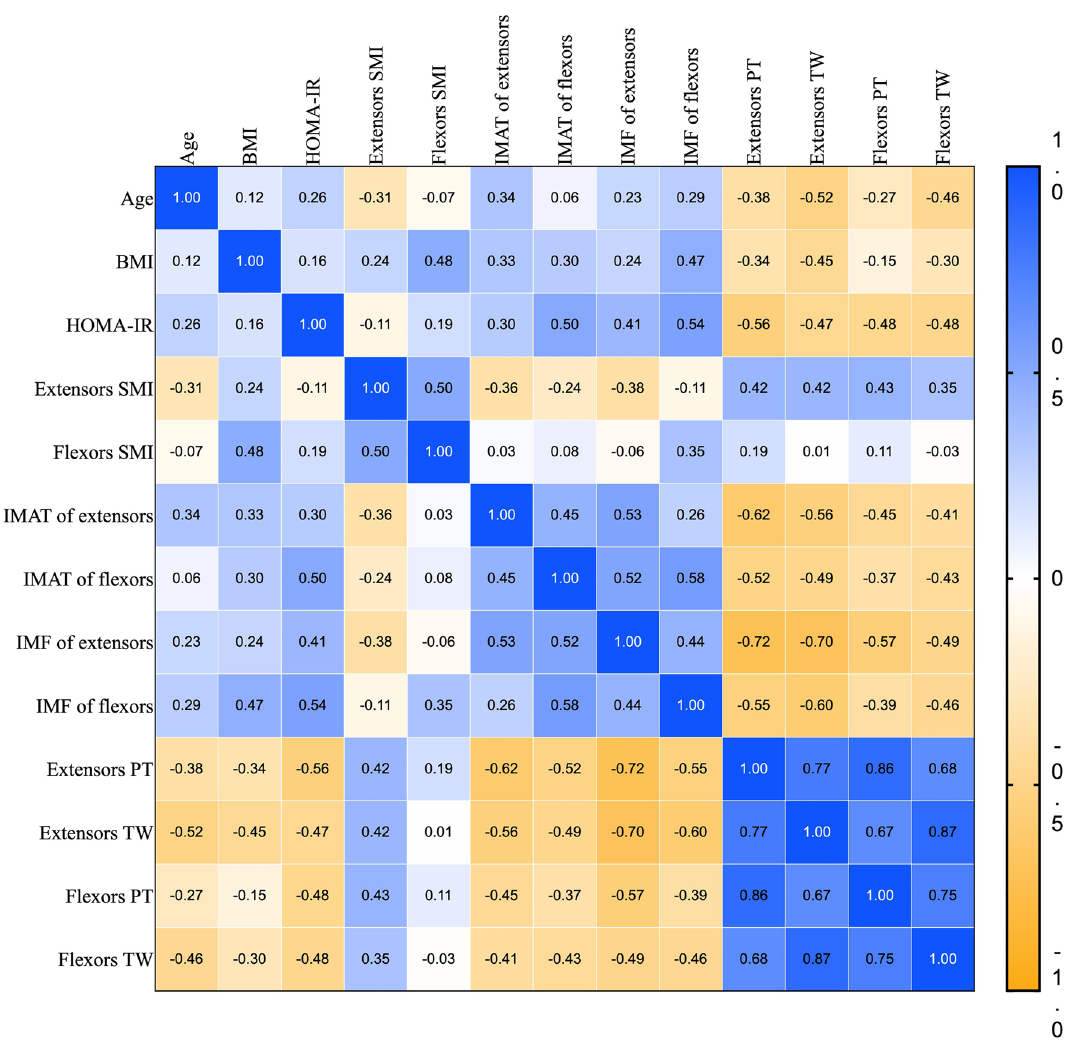
Figure 6. Heatmaps of correlation coefficients clinical characteristics, muscle PDFF and isokinetic muscle strength in patients with T2DM. BMI, body mass index; HOMA-IR, homeostasis model assessment-insulin resistance; SMI, skeletal muscle index. IMAT, intermuscular adipose tissue; IMF, intramuscular fat; PT, peak torque; TW, total